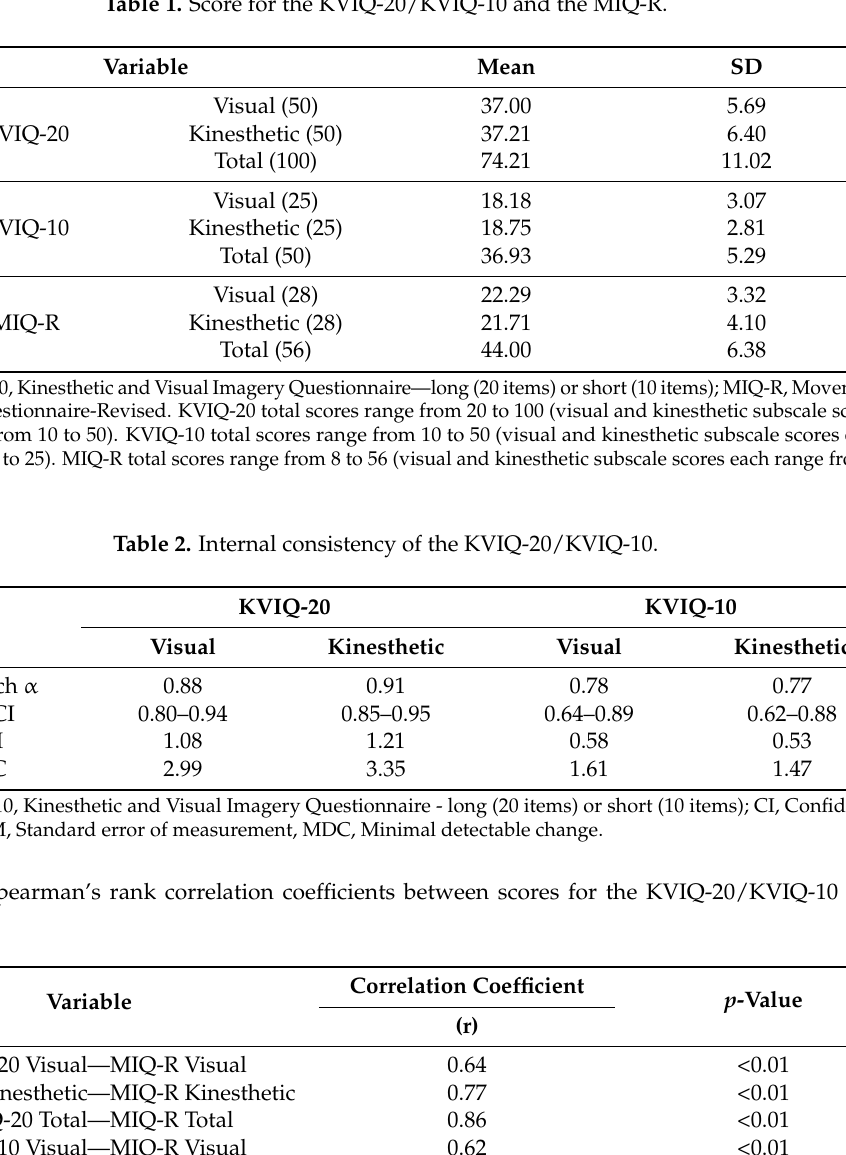
Table 1. Score for the KVIQ-20/KVIQ-10 and the MIQ-R.